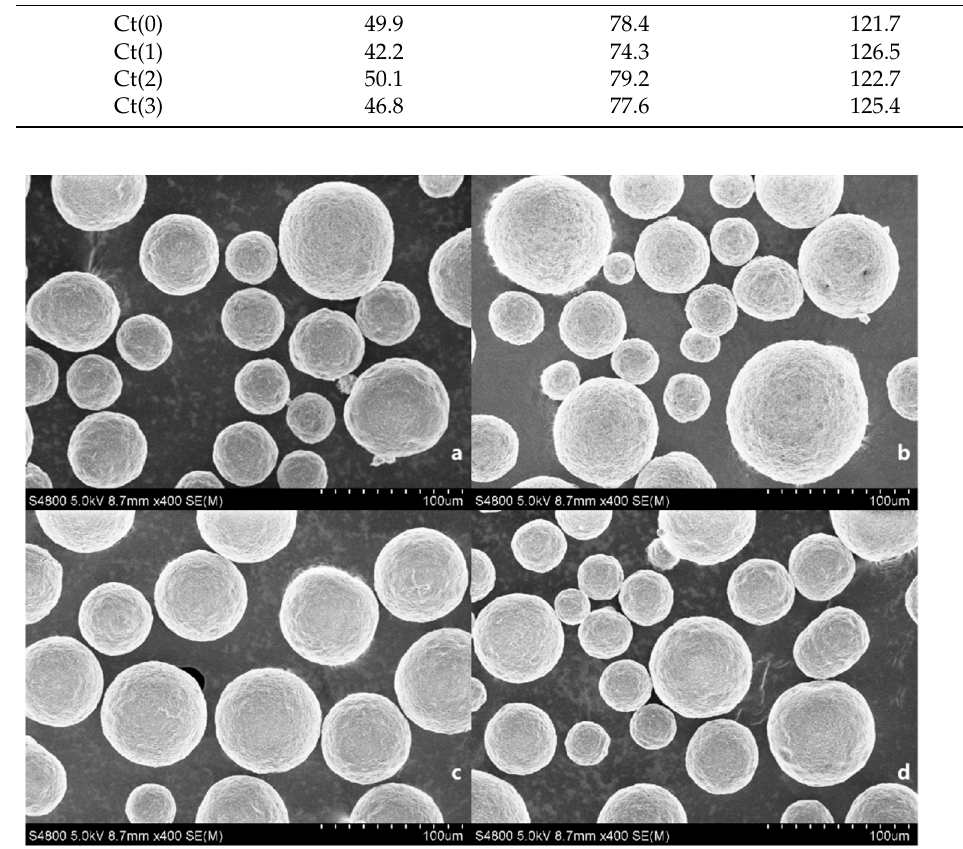
Figure 5. SEM images of the as-formed titanium-containing mesoporous silica catalysts ( a ) Ct(0); ( b ) Ct(2); ( c ) Ct(3); and ( d ) Ct(4).